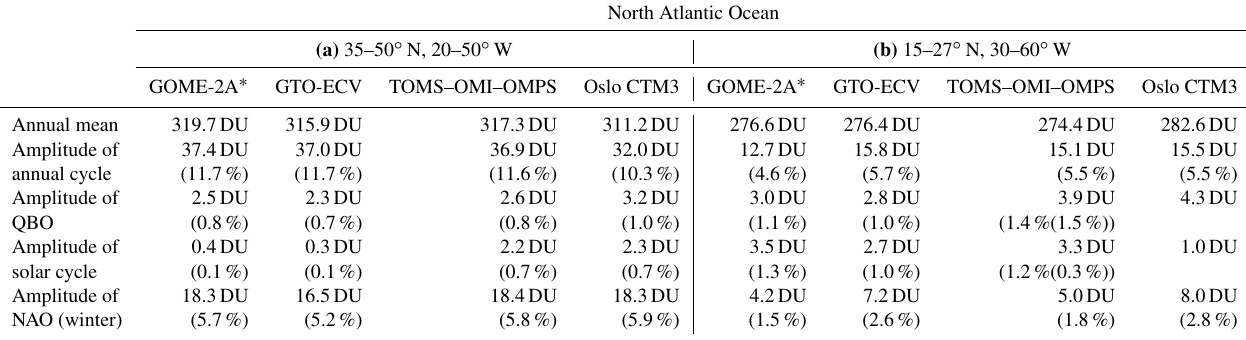
Table 6. Annual mean total ozone, amplitude of annual cycle, amplitude of QBO, amplitude of solar cycle, and amplitude of NAO in the period 1995–2016 from GOME-2A, GTO-ECV, the combined TOMS–OMI–OMPS satellite data, and Oslo CTM3 model calculations over the North Atlantic Ocean, in (a) region 35–50 ◦ N, 20–50 ◦ W, and (b) region 15–27 ◦ N, 30–60 ◦ W.